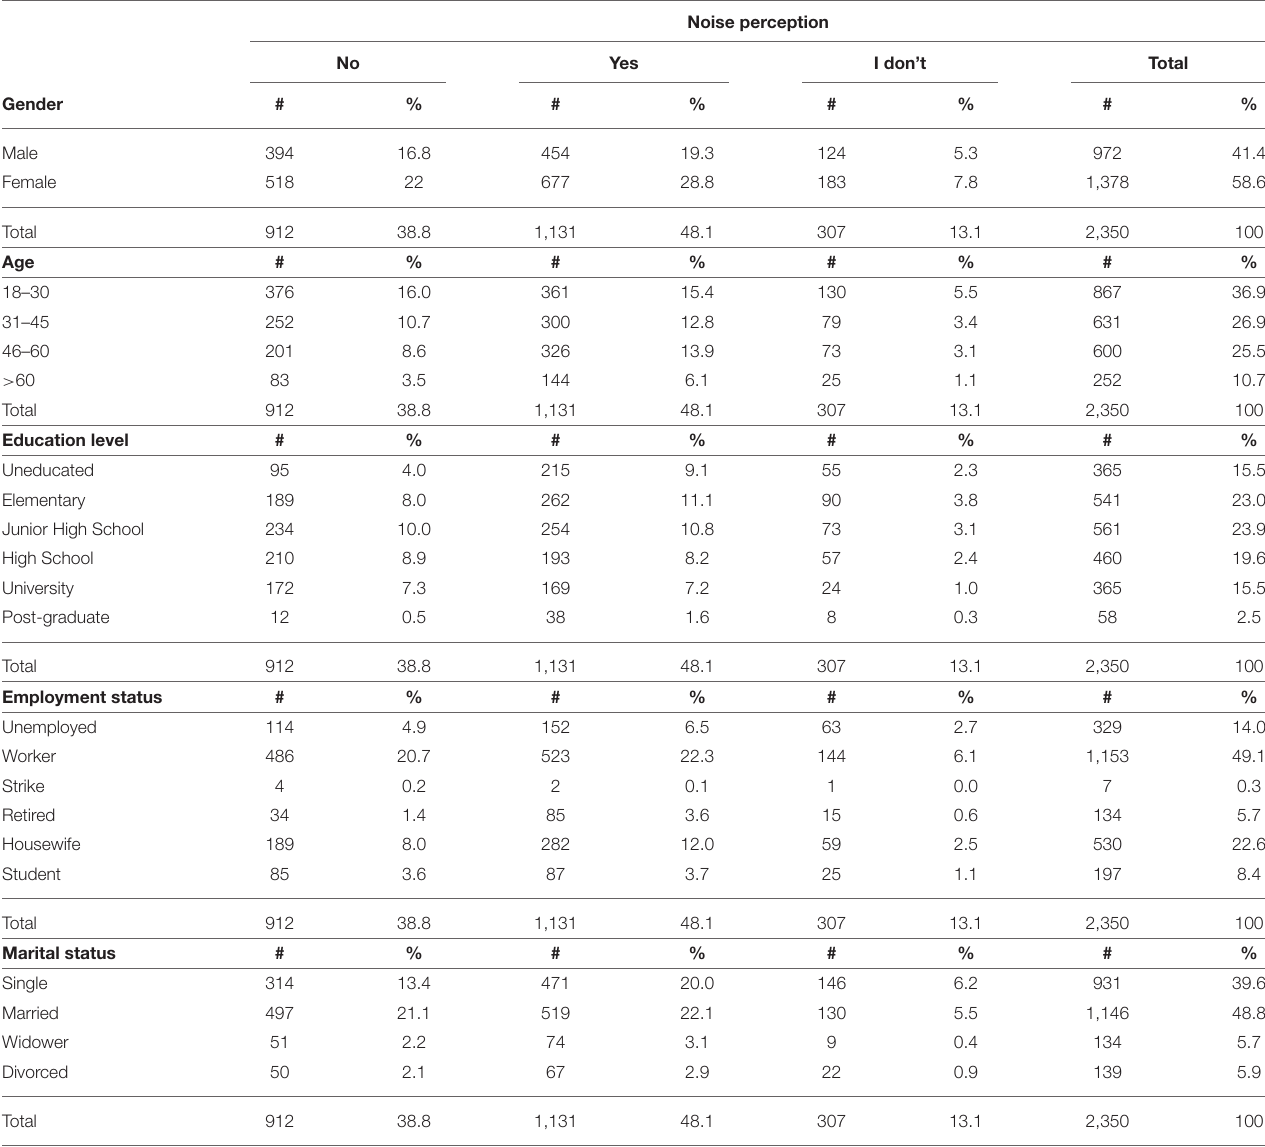
TABLE 2 | Demographic data and noise perception.